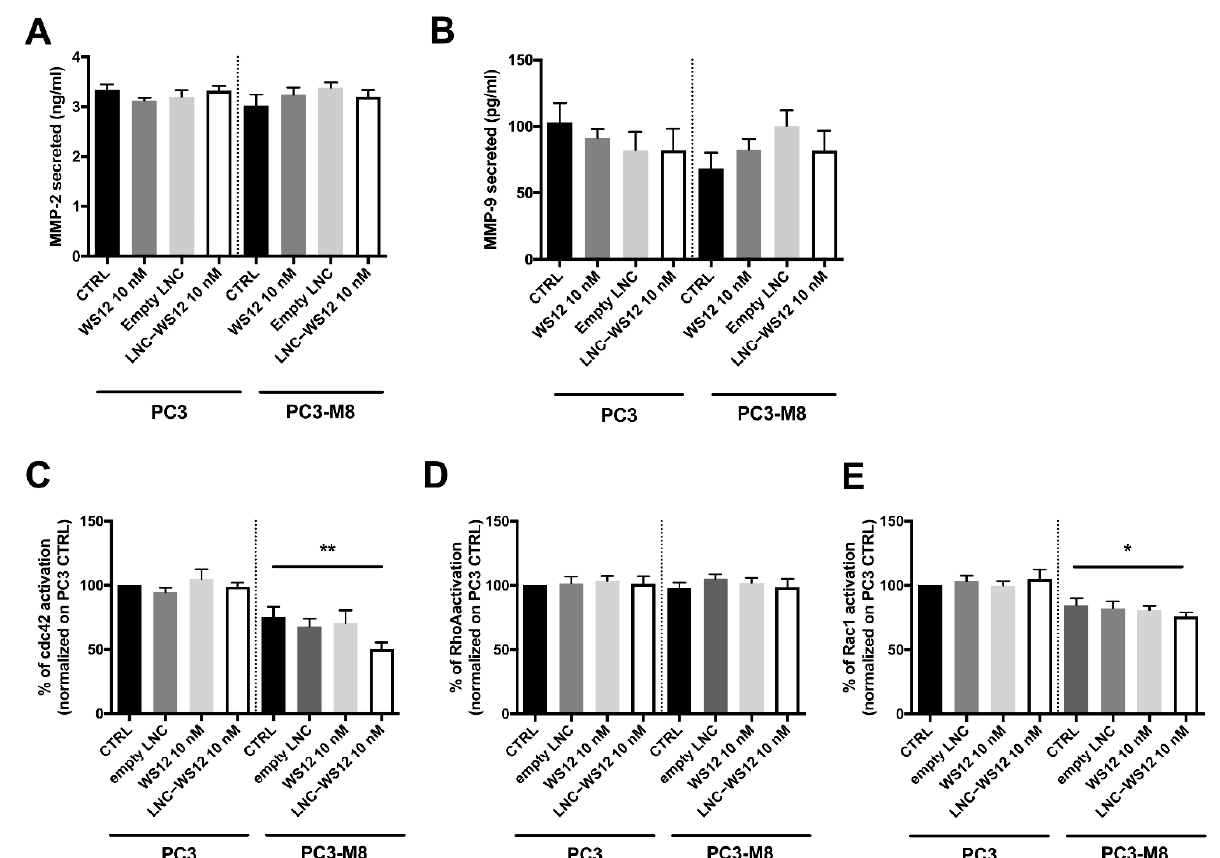
Figure 7. TRPM8 does not affect MMP secretion but modulates Rho GTPase signaling pathway. ( A , B ) MMP–9 ( A ) and MMP–2 ( B ) secretion in PC3 luc and PC3–M8 luc treated with WS12 (10